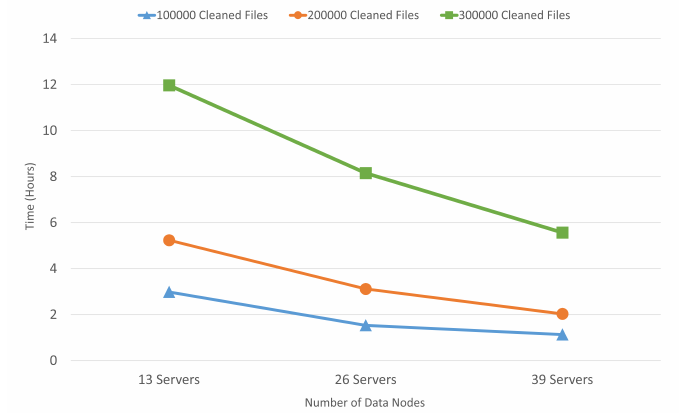
Figure 2. Time comparison between different Hadoop data node